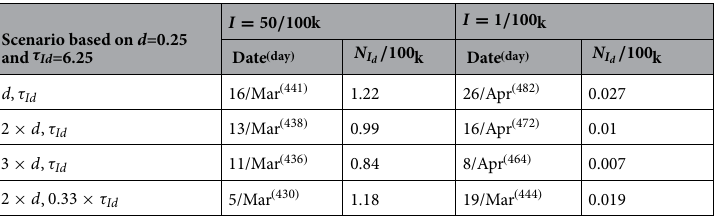
Table 3. Summary of 2021 dates when the silent spreaders number decreases, either to 50 per 100k or to 1 per 100k, and respective daily new cases obtained for the different scenarios projected in Fig. 5. The numbers in superscript correspond to the number of days elapsed from January 1, 2020.